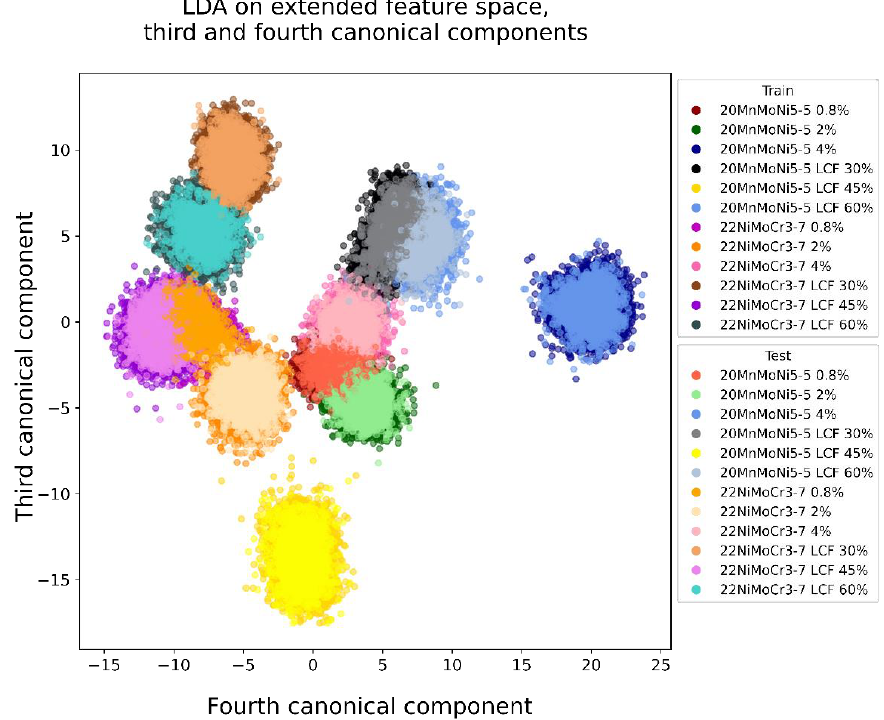
Figure 11. Stress-independent microstructure characterization of the first four canonical components transformed by LDA, extended feature space.